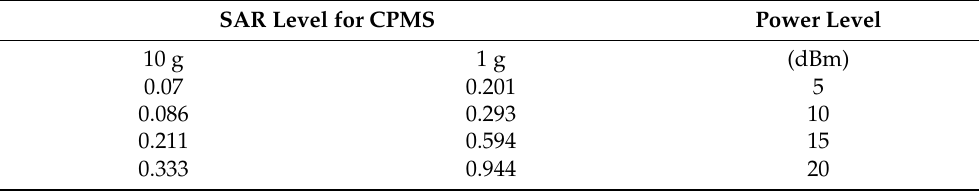
Table 2. Comparison of measured SAR levels for the circularly polarized monopole sensor.